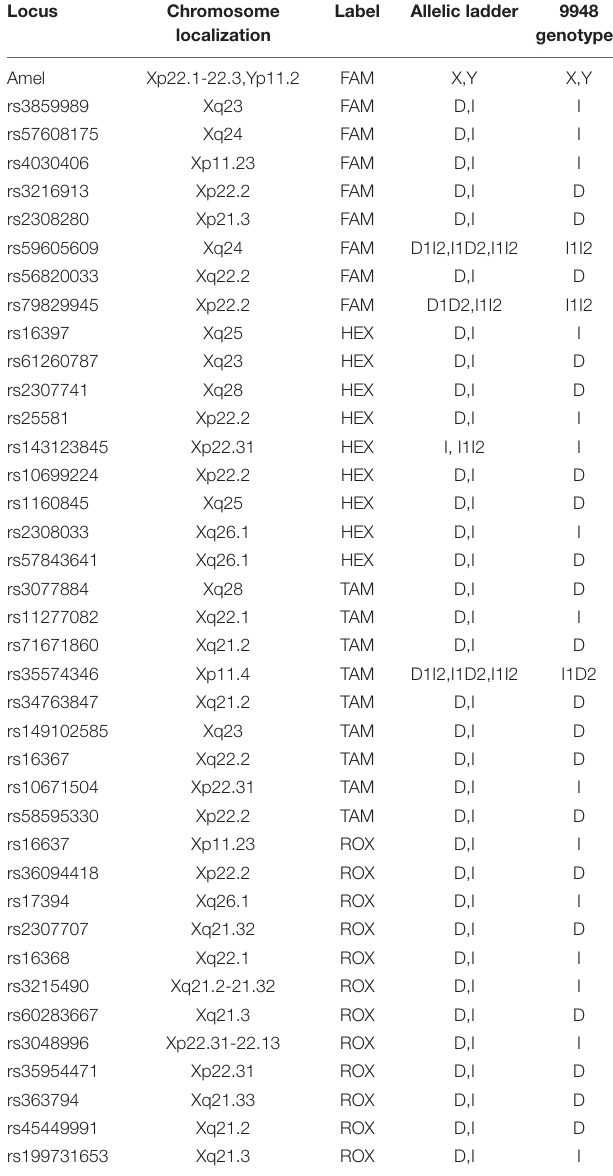
TABLE 1 | The information of 38 X-InDel loci and amelogenin presented in the AGCU X-InDel 38